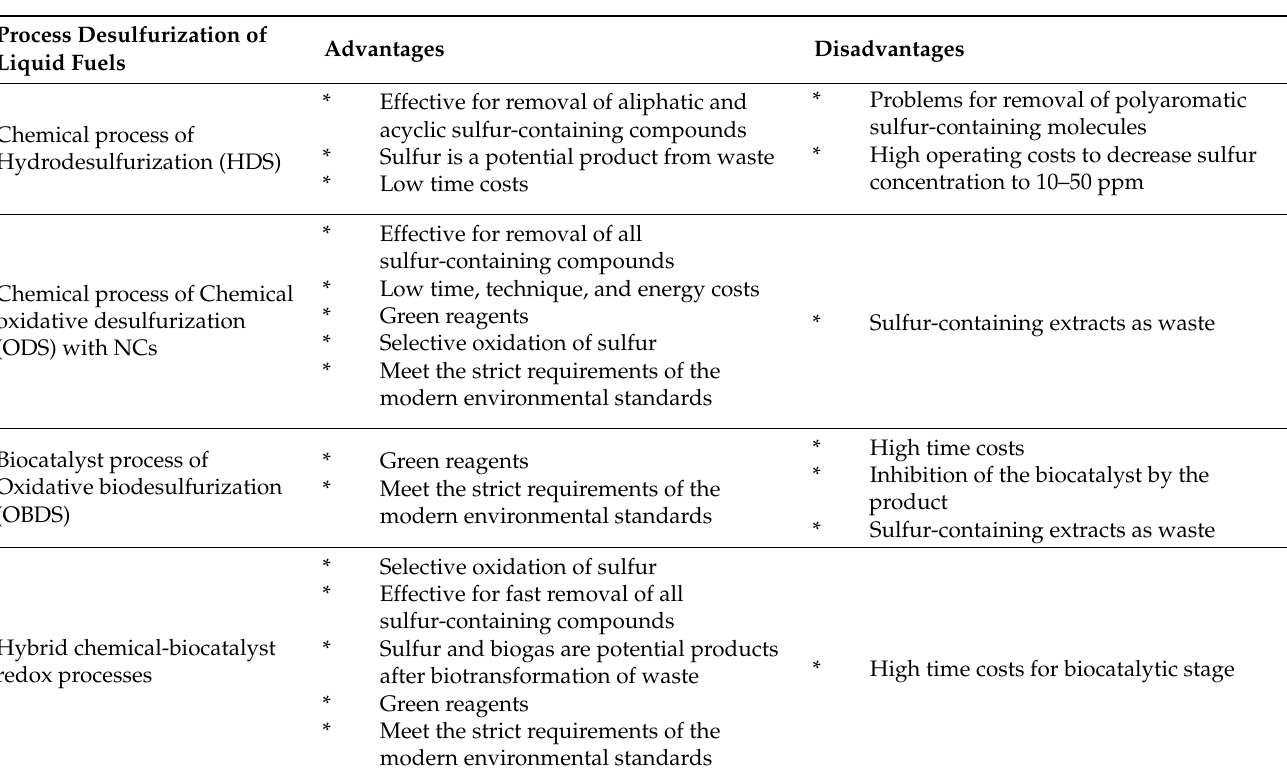
Table 6. The advantages and disadvantages of chemical and biocatalyst process including in the view of the hybrid chemical-biocatalytic